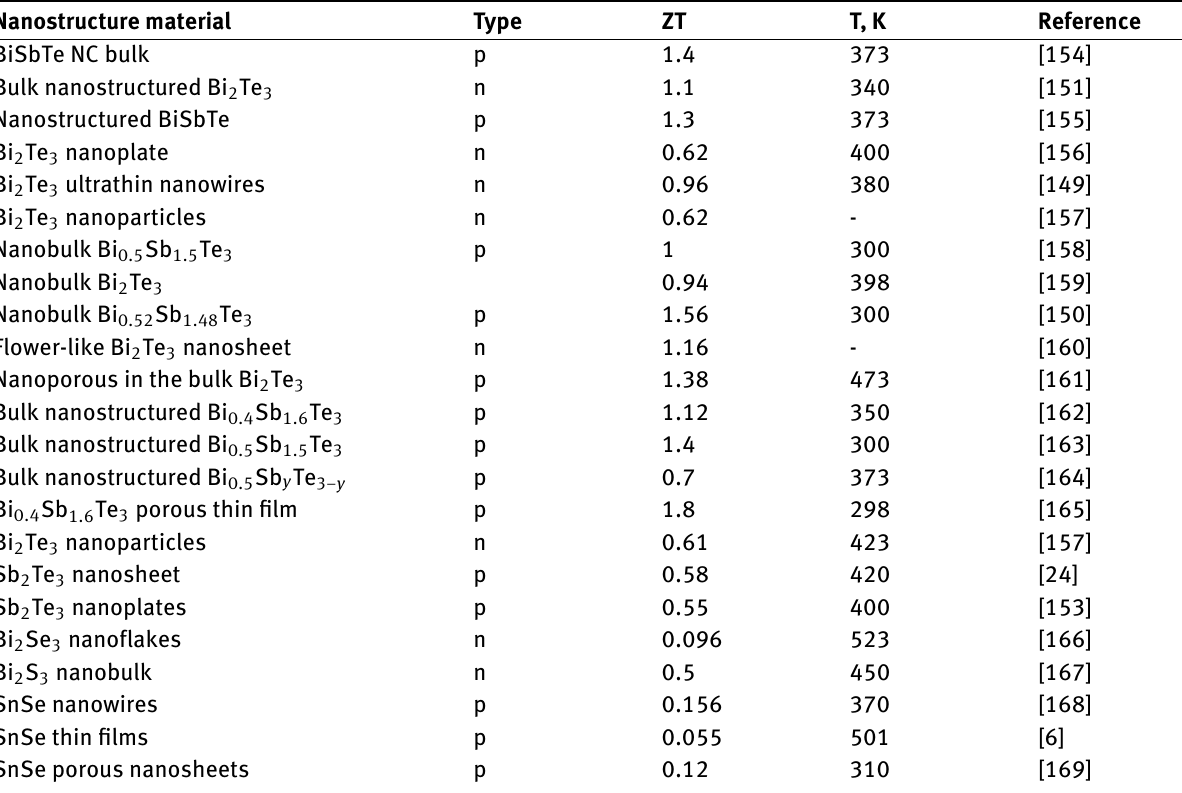
Table 3: ZT of some layered chalcogenides nanostructures. Nanostructure